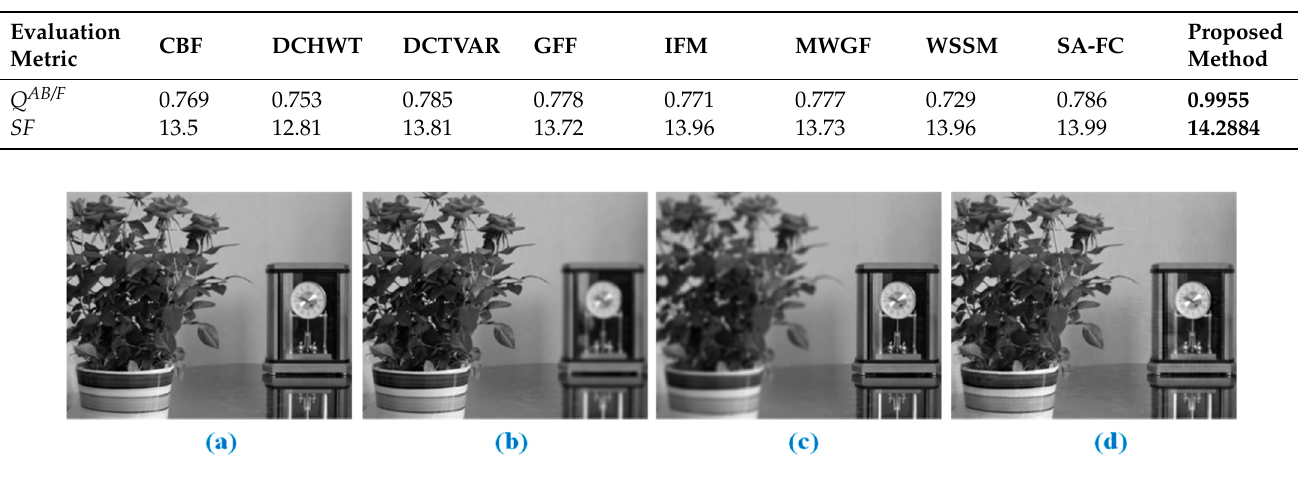
Figure 16. (Flowerpot): ( a ) original image; ( b , c ) multi-focus input images; and ( d ) proposed fusion.